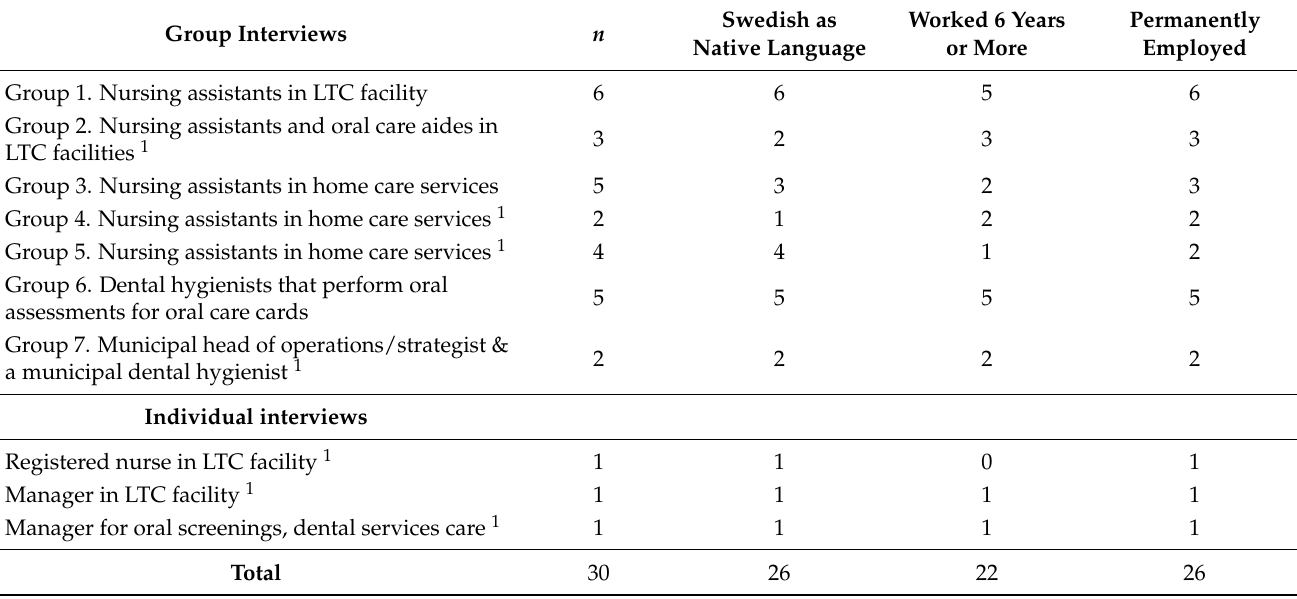
Table 1. An overview of the distribution of participants according to type of interview, native language, and